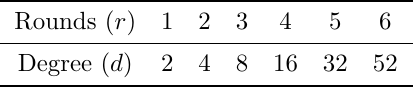
Table 8: Upper bounds on the ANF degree after r quadratic (degree 2) round functions of 53 bits as used for the tweak